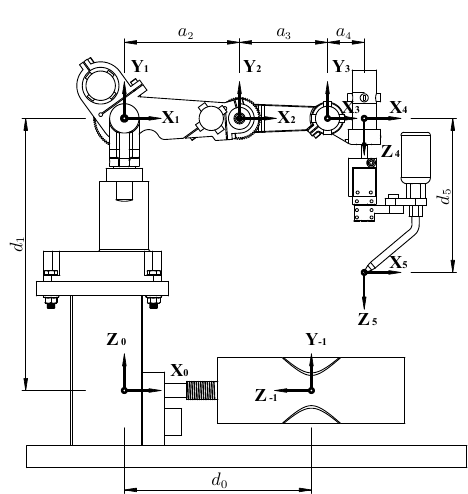
Fig. 4: The model of